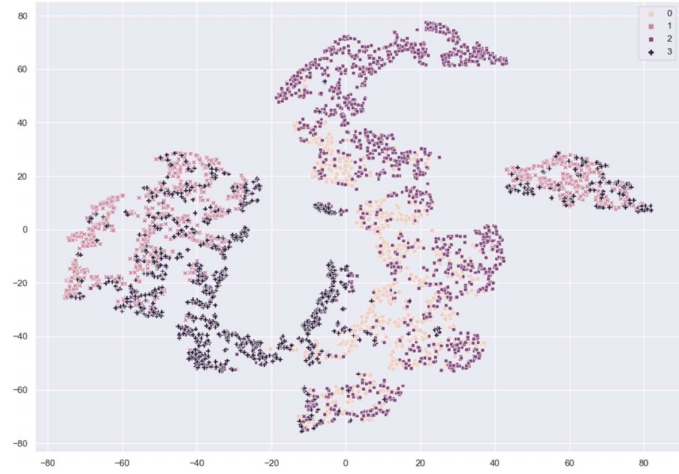
Figure 8. The distribution of fingerprint samples before adaptation in the cross-sensor. 0: train live, 1: train fake samples from CrossMatch sensor, 2: test live, 3: test fake samples from Biometrika